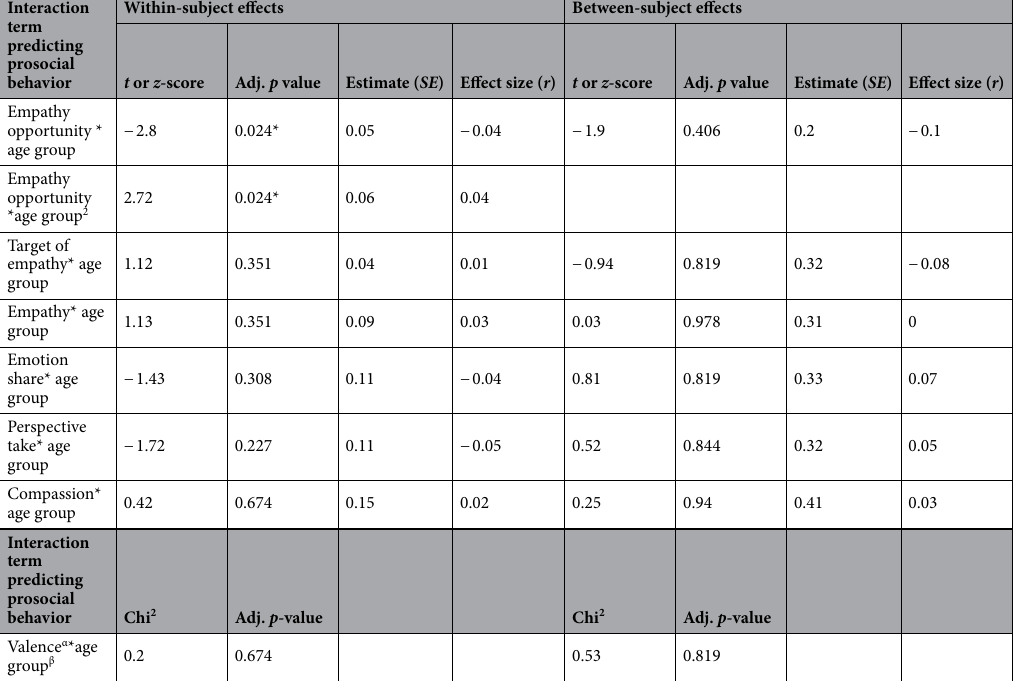
Table 1. Within- and between person effects of different interactions regarding different aspects of daily empathy and age predicting daily prosocial behavior. Prosocial behavior was included in all models as binary outcome variable. Statistics obtained from mixed models, nested within participant and survey day. Each interaction ran in a separate model, with age as linear and quadratic term separately. Model selection was conducted based on a loglikelihood ratio test. P values were adjusted to control the false discovery rate. * p < 0.05. α Positive, negative, or neutral target emotion. β Reduced random effect structure due to convergence warnings, only nested within